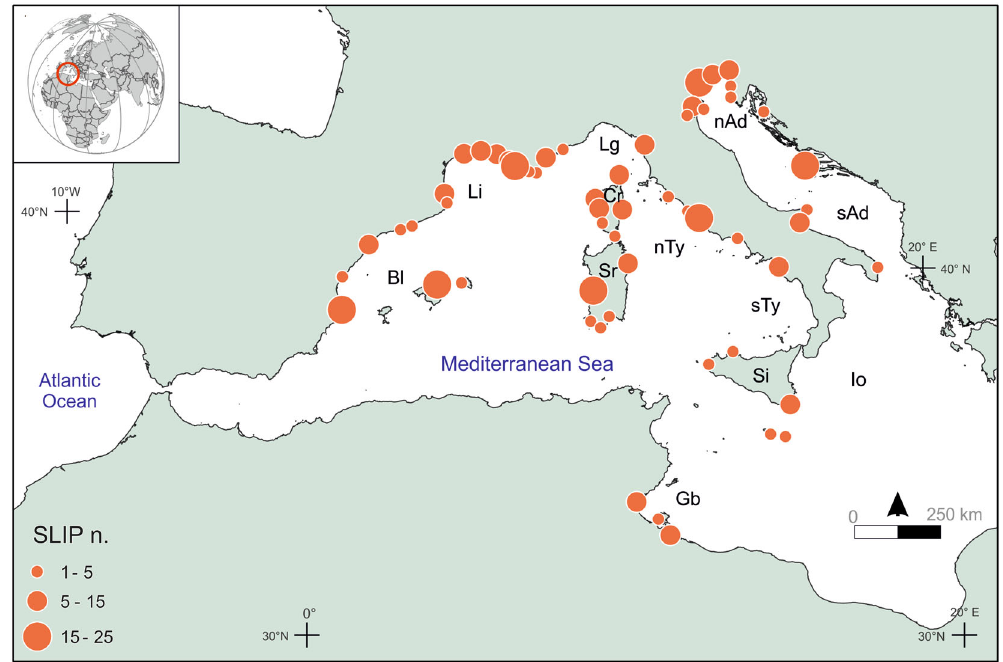
Fig. 1 Spatial distribution of the central and western Mediterranean sea-level index points (SLIPs) used for this analysis. Br is the Balearic Sea; Li is the Gulf of Lion; Lg is the Ligurian Sea; nTy is the northern Tyrrhenian Sea; sTy is the southern Thyrrenian Sea; Gb is the Gulf of Gabes; Io is the Ionian Sea; nAd is the northern Adriatic; sAd is the southern Adriatic Sea; Sr is Sardinia Island; Cr is Corsica Island; Si is Sicily